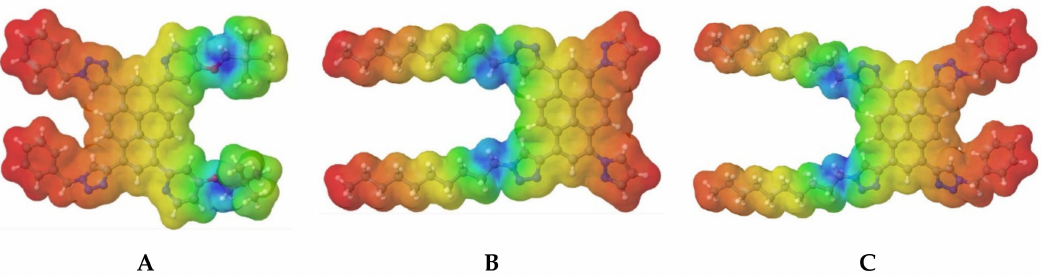
Figure 3. Electrostatic potential energy maps calculated at the B3LYP/6-31G(d,p) level for A – C . The molecular electrostatic potential maps describe the nucleophilic and electrophilic sides. The red areas depict the electrophilic activity corresponding to the electron-rich areas, whereas the blue areas indicate nucleophilic activity corresponding to the electron- deficient areas. The results show that triazoles substituted by the decyl group have the highest nucleophilic potential, whereas triazoles substituted by the benzyl group exhibit electron-rich areas.